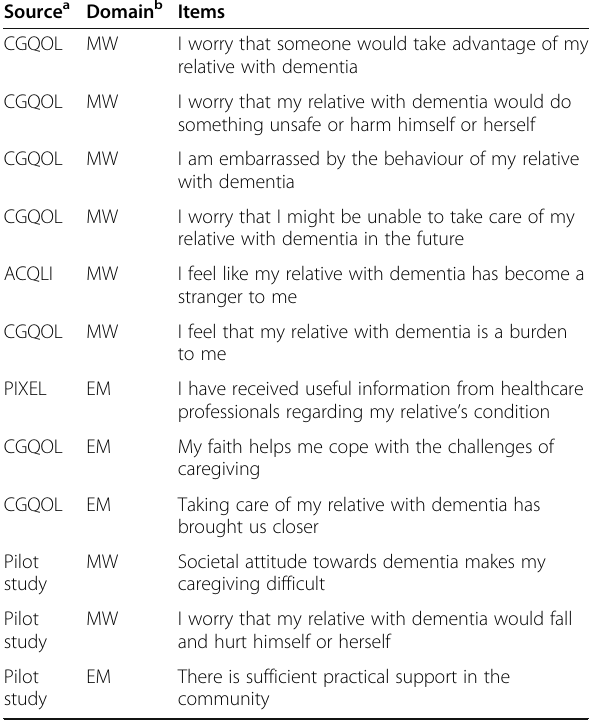
Table 1 Candidate items identified from review of dementia literature and pilot